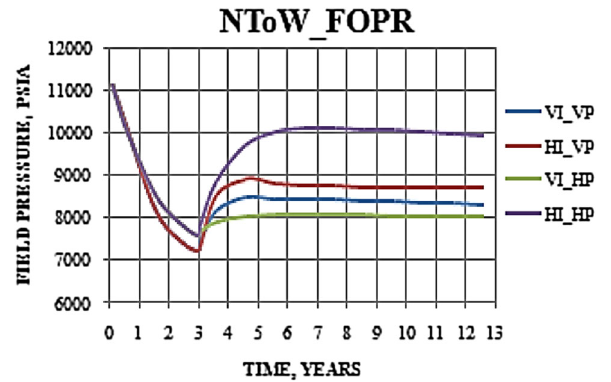
Fig. 25 Plot of the field pressure versus time for different